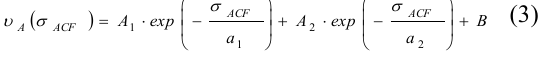
The calculated coefficient of determination R 2 = 0.998 indicates the good fit of the curve to the measuring points. Analysis with the use of uncertainty propagation method [14] shows that the air velocity can be measured to an accuracy of 8.5% of its value. The main influence on measurement uncertainty is σ ACF value which is the smaller the larger the velocity determination error is. It should be noted that the presented calibration curve applies only to the described flow conditions. In case of different air flow, the measuring system should be calibrated